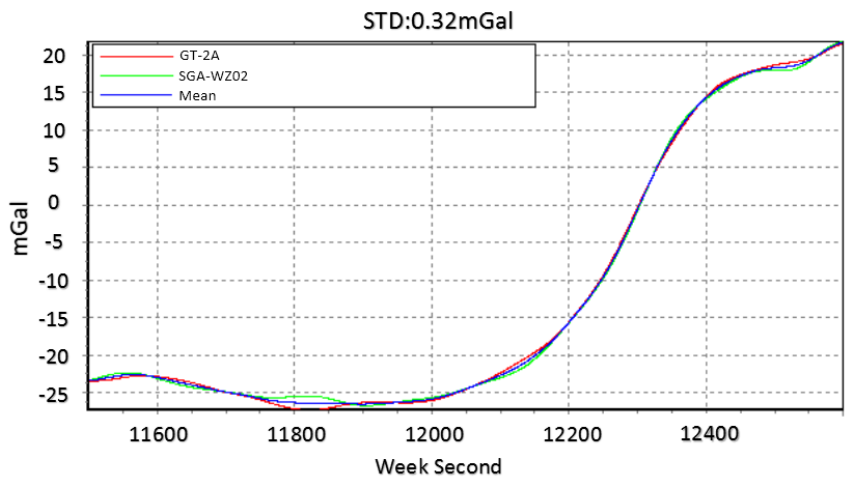
Figure 14. Results of normal lines using two algorithms.